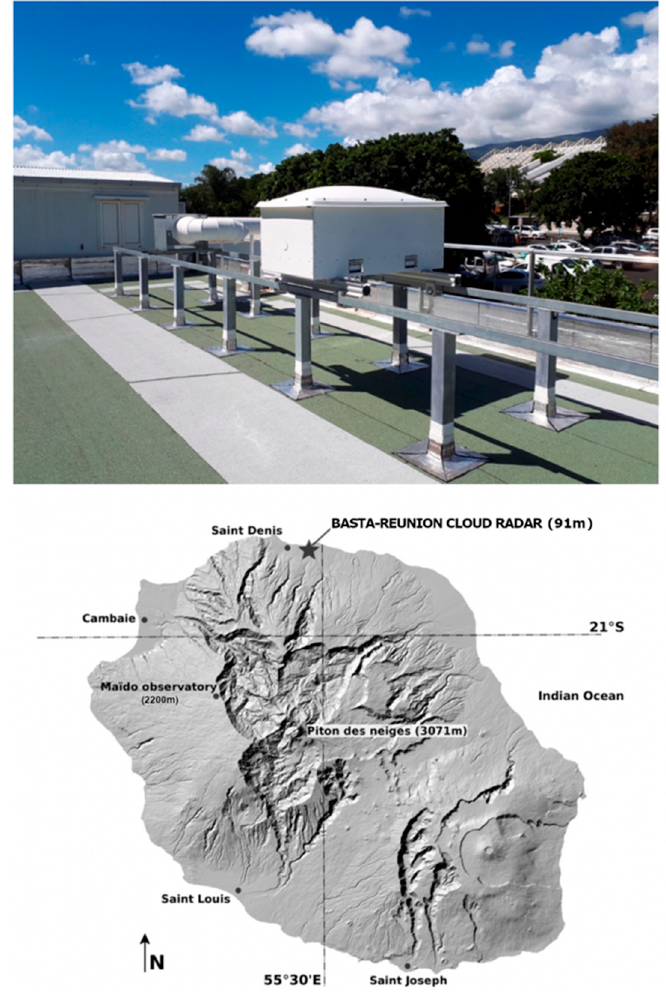
Figure 1. The cloud radar BASTA ‐ REUNION located in Saint ‐ Denis de La Réunion on the rooftop of Reunion University (55.48° E, 20.9° S).